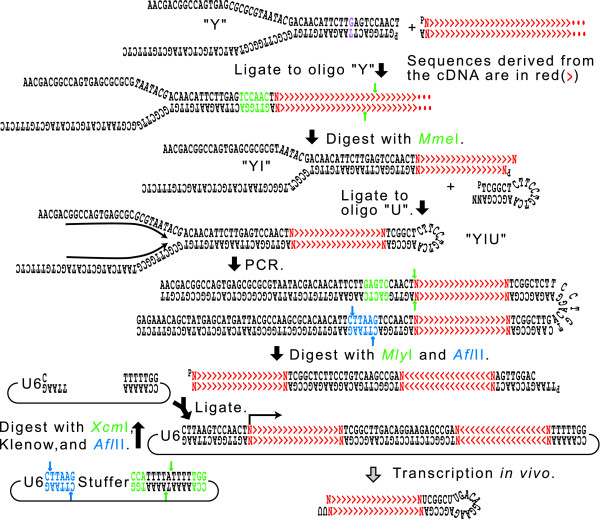
See text for details. A single G-T mismatched is shown in purple. Restriction enzyme recognition sites are shown in green or blue, and sites of cleavage by arrows. The structure of the KSU6 vector is shown in the lower left.